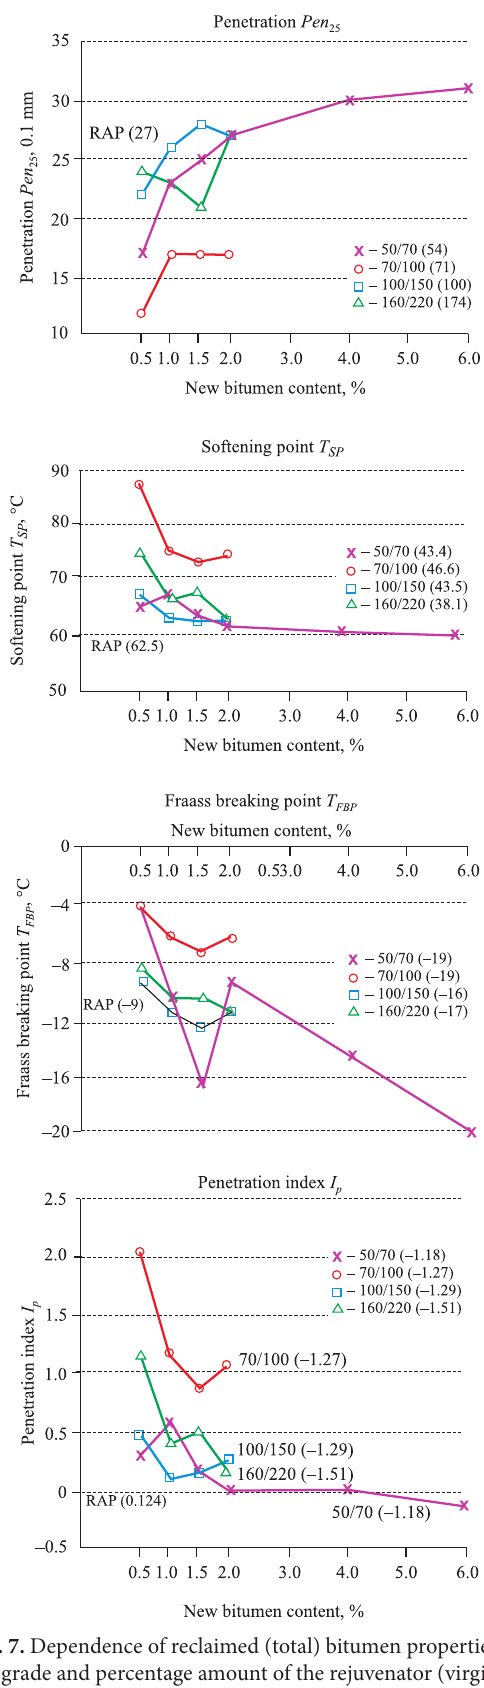
Fig. 7. Dependence of reclaimed (total) bitumen properties on the grade and percentage amount of the rejuvenator (virgin bitumen) in RAP mixture. RAP bitumen and rejuvenating bitumen properties are presented in brackets